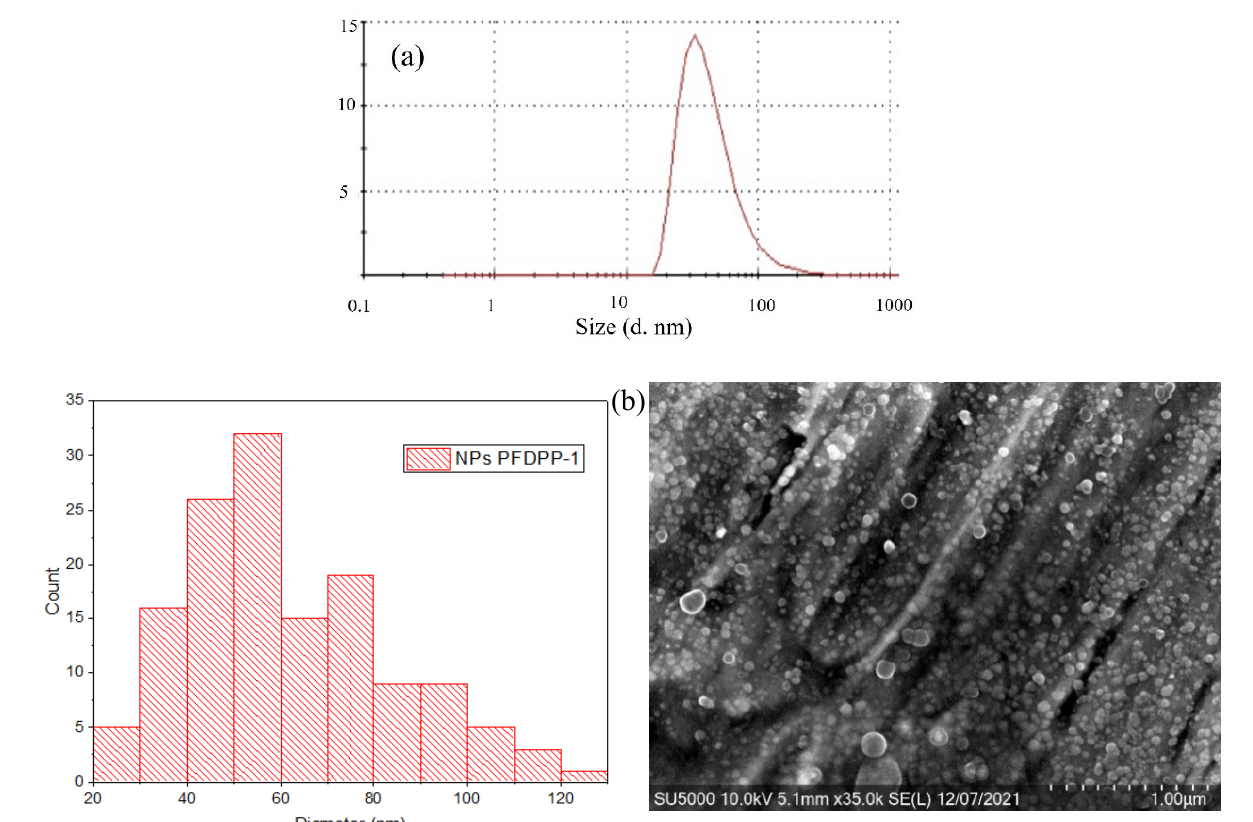
Figure 9. ( a ) Diameter of nanoparticles measured by DLS, ( b ) micrograph and size distribution of PFDPP-1 NPs.